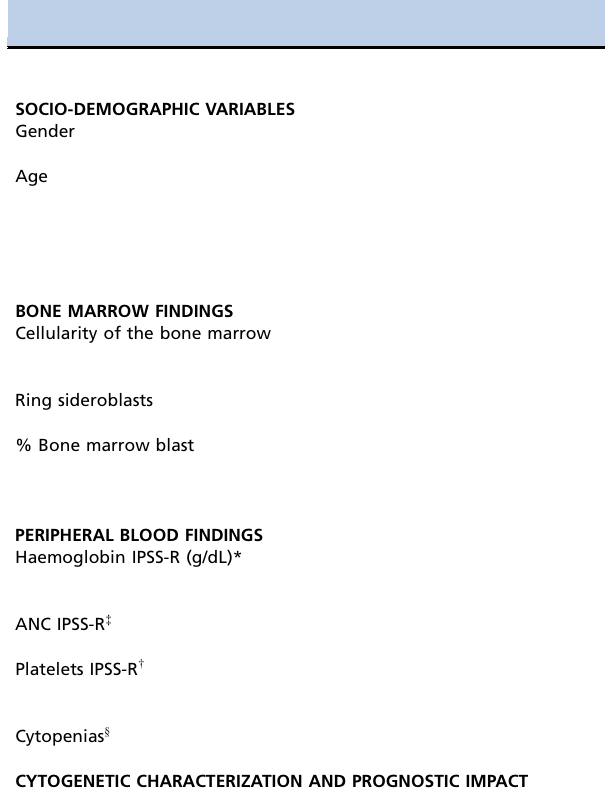
Table 1 - Response to EPO alfa treatment according to the clinical-laboratory characteristics of the study population (n=36).